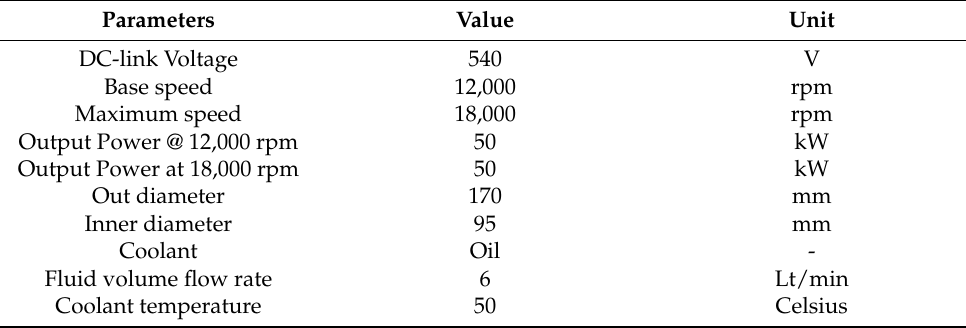
Table 1. The specifications of the permanent magnet starter–generator